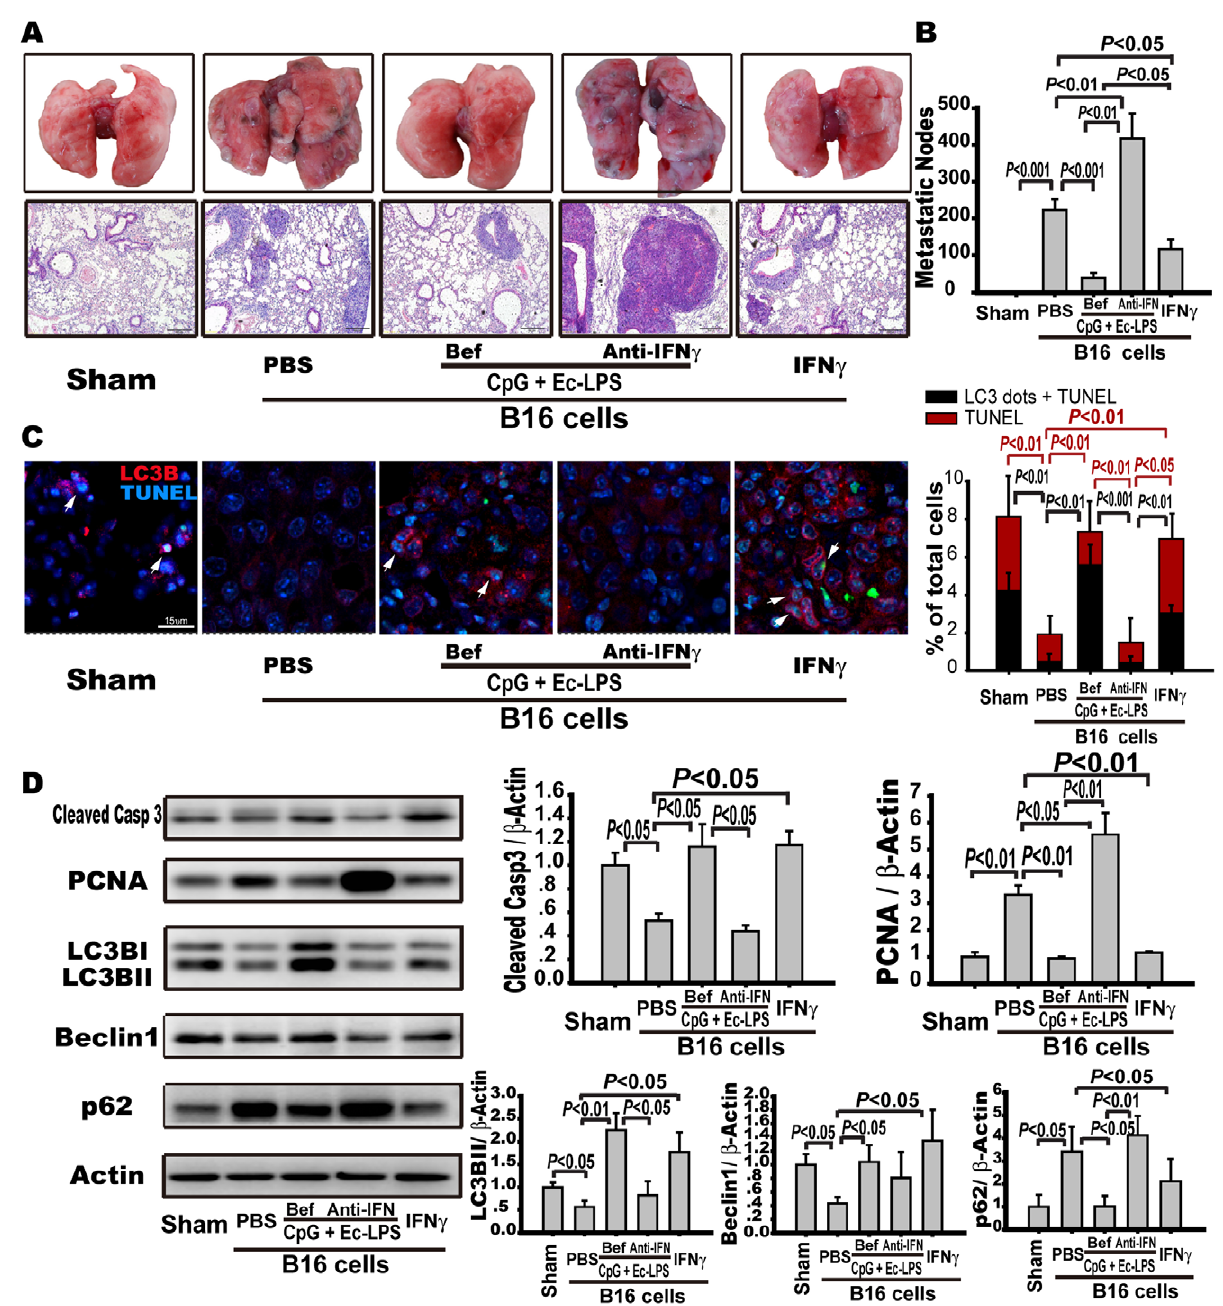
Figure 4. IFN c neutralization reverses the protective role of TLR4/TLR9 agonist complex against tumor metastasis. C57BL/6 mice were injected with B16-F10 melanoma cells (5 6 10 5 ) and humanely sacrificed 14 days after tumor cell inoculation. The mice were intraperitoneally treated with the TLR4/TLR9 complex (dosage and frequency as in Fig. 1) with or without an IFN c -neutralizing antibody (100 m g/mouse) or human recombinant IFN c (1 6 10 6 U/kg once a day) before tumor cell inoculation. Control animals were treated with PBS. Externally visible metastases on the lung surface were counted, as described in the legend of Figure 1. (A) Representative lung samples and representative pulmonary H&E staining (magnification: 100 6 ). (B) Metastatic nodules were summarized. Data are the mean 6 S.E. (n=10). (C) Effects of targeting IFN c on apoptosis or autophagy-associated cell death were evaluated by confocal analysis of LC3 immunostaining (red) and TUNEL (green) in metastatic nodes of lung tissue sections. Left panels are representative immunofluorescence microphotographs of LC3B and TUNEL. Arrows point to cells with LC3 dots and TUNEL-positive nuclei. Scale bar: 15 m m. Right panel is a bar graph to show the percentage of cells with TUNEL-positive nuclei or with TUNEL positive nuclei and LC3 dots relative to the total number of cells in each section. Twelve images from each lung specimen were counted. Data are the mean 6 S.E (n=6 mice/group). (D) The expression of apoptosis and autophagy-related proteins in lung tissues as indicated was detected by Western blots. Representative immune blots are shown in the left panel, and the statistical results are shown in the right panel. Data are presented as the mean 6 S.E. (n=5 mice per group).